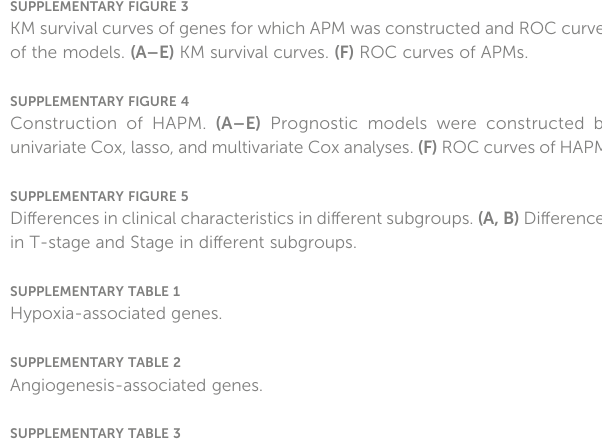
SUPPLEMENTARY TABLE 1 Hypoxia-associated genes. SUPPLEMENTARY TABLE 2 Angiogenesis-associated genes. SUPPLEMENTARY TABLE 3 Results of the four